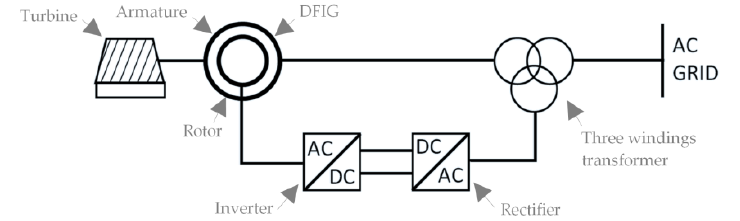
Figure 2. Use of a double-fed asynchronous machine.